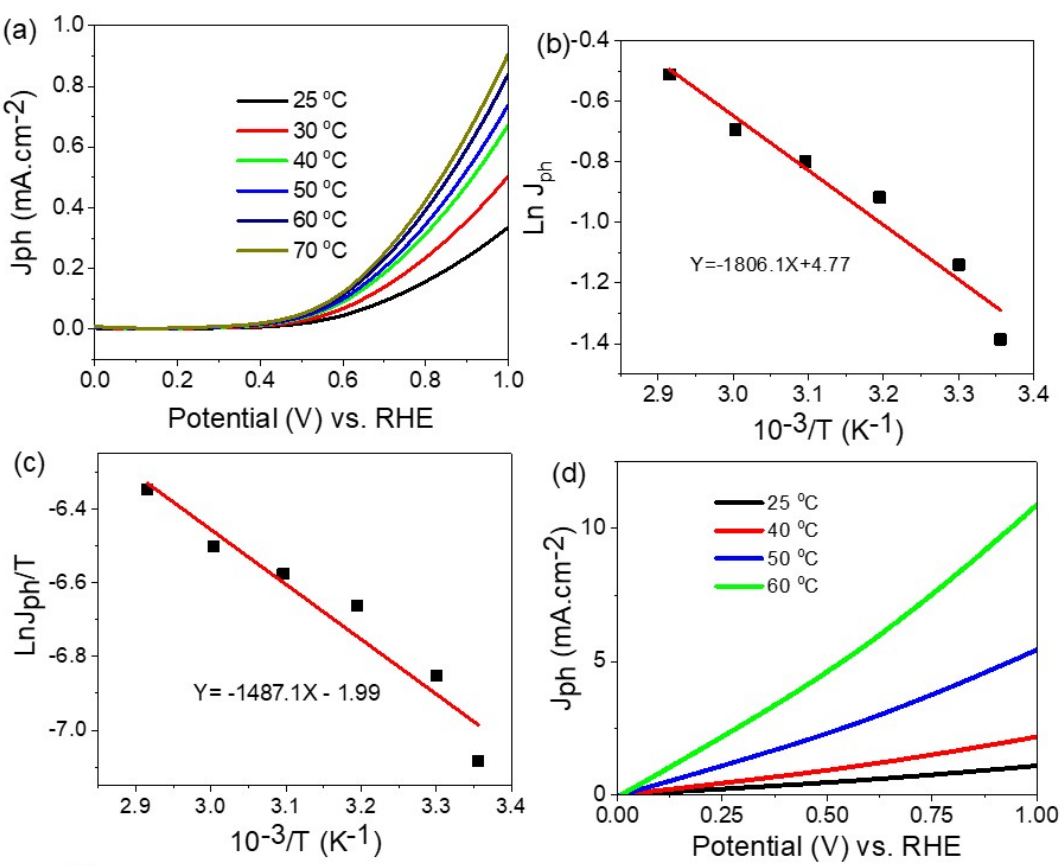
Figure 7. ( a ) The effect of the temperature on the produced J ph value, ( b ) the Arrhenius relation, and ( c ) the Eyring relation for the PMT/Au-2 min electrode using the Na 2 S 2 O 3 electrolyte. ( d ) The effect of the temperature on the produced J ph value for PMT/Au-2 min electrode using sewage water as the electrolyte.